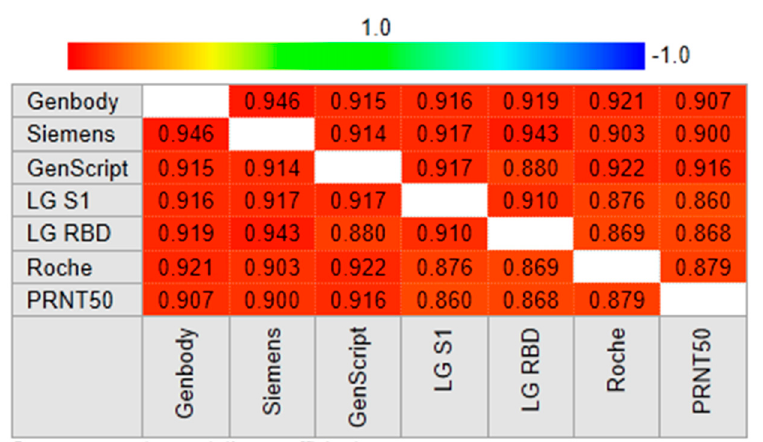
Figure 4. Spearman rank correlation coefficients for relationships between SAS-CoV-2 antibody assay results using 90 PRNT-positive samples from vaccinated participants.